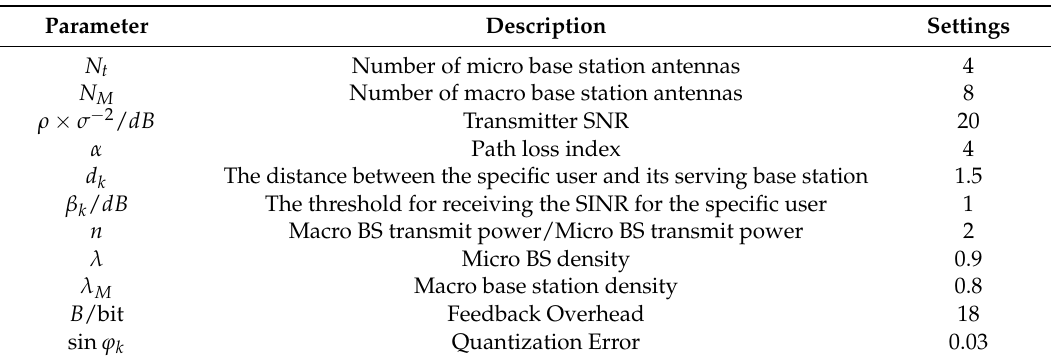
Table 1. Simulation